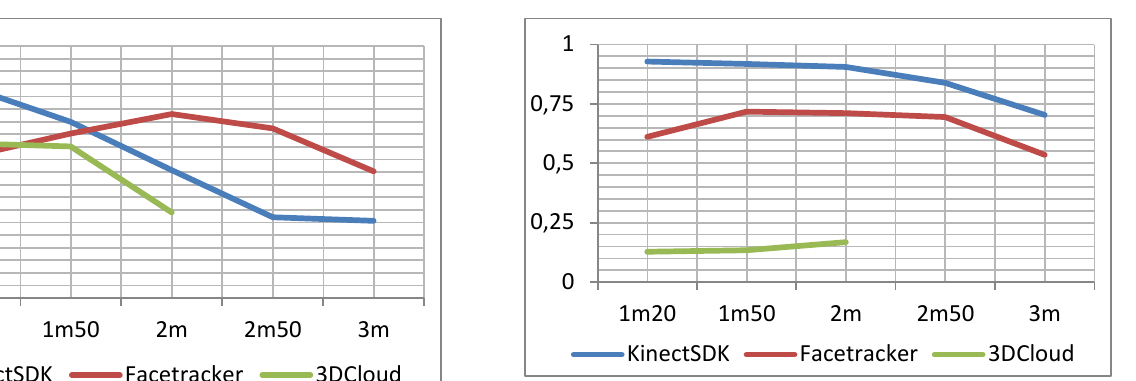
Figure 17. Mean correlation for the roll function of the viewer distance from TV (in m).